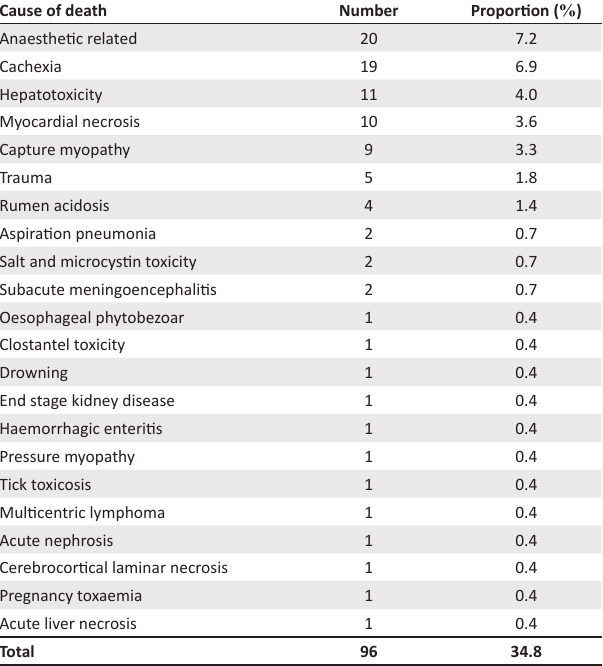
TABLE 3: Cause of death in 275 African buffaloes: Non-infectious diseases. Cause of